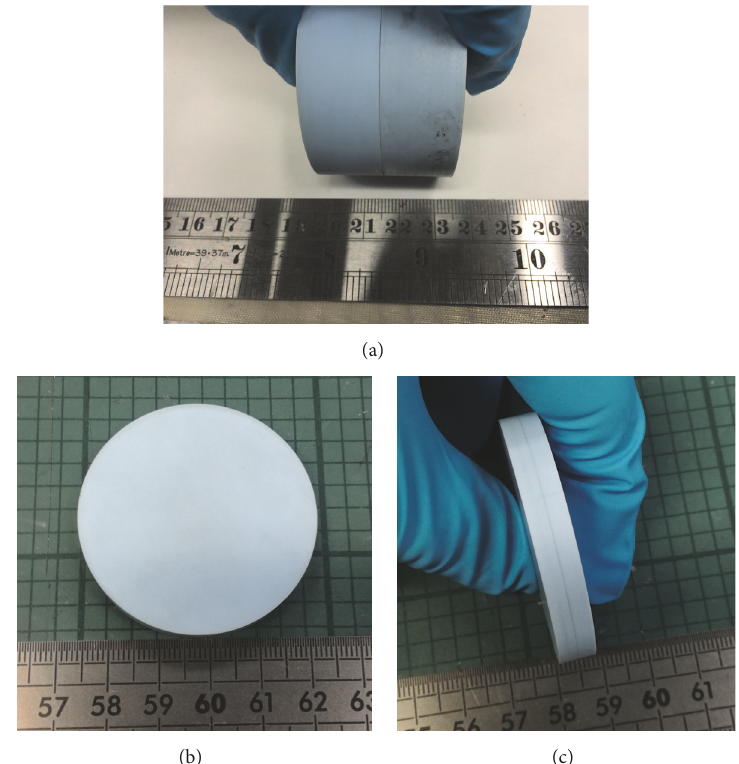
Figure 4: Lens fabrication at QinetiQ: (a) lens prior to final milling; (b) front view of lens after milling; (c) side view of lens after milling.